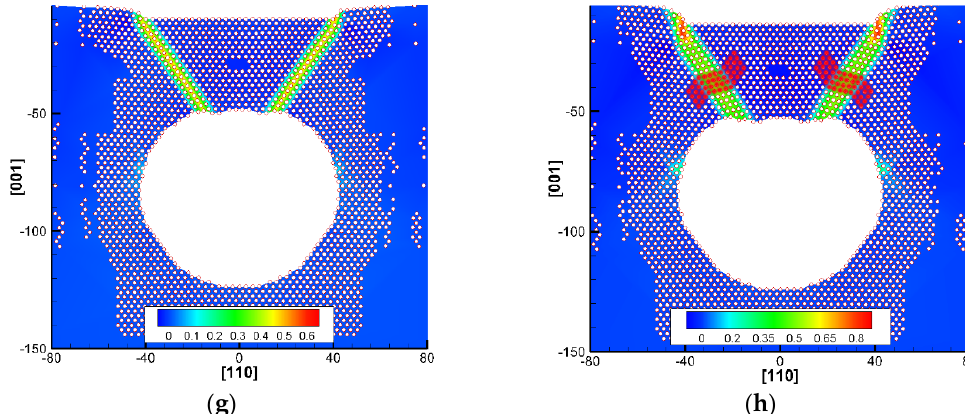
Figure 5. ( a ) Contact stiffness ( S c ) and ( b ) yield stress ( σ y ) of Al containing a circular cavity with different diameter ( D ) during nanoindentation. The dislocation morphology in the matrix ( c , e , g ) at the yield point and ( d , f , h ) further yielding with the cavity ( D = 40 Å , H = 40 Å , S = 80 Å ), ( D = 60 Å , H = 40 Å , S = 80 Å ) and ( D = 80 Å , H = 40 Å , S = 80 Å ).